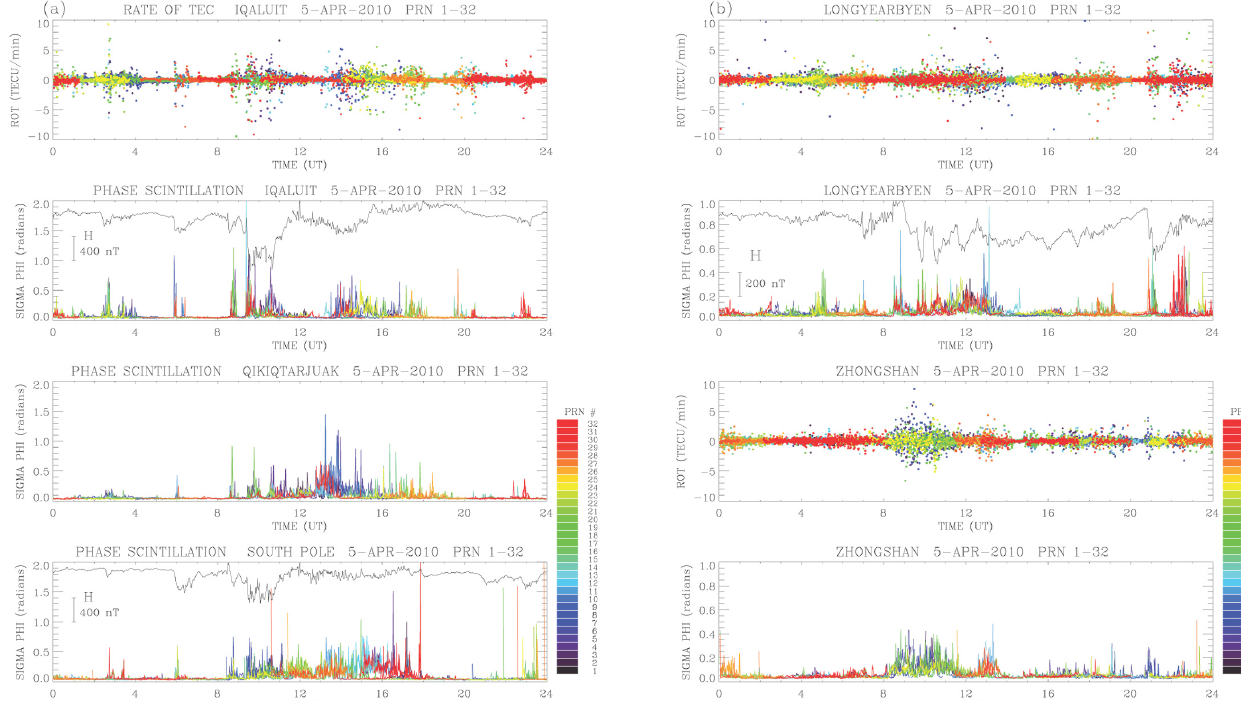
Fig. 6. The rate of TEC (ROT) change and phase scintillation index σ 8 observed at elevations above 20 ◦ in (a) Iqaluit, Qikiqtarjuaq and South Pole and in (b) Longyearbyen and Zhongshan stations on 5 April 2010. Superposed in the scintillation panels for Iqaluit, South Pole and Longyearbyen is the H component of the ground magnetic